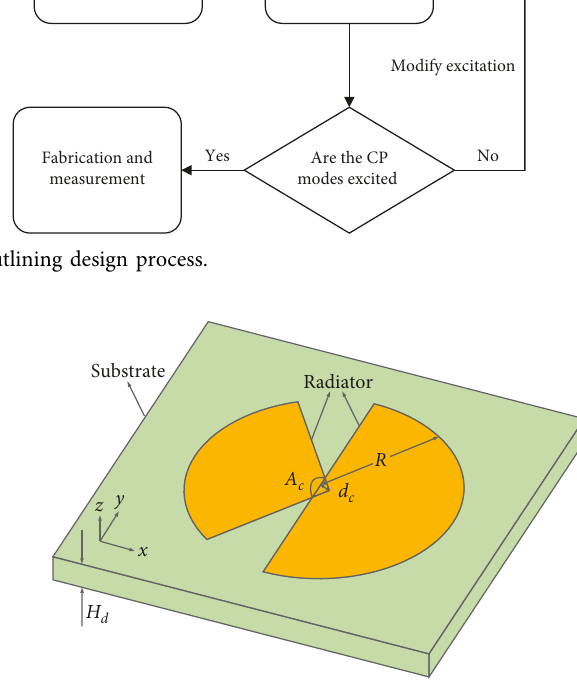
Figure 2: Geometry of the radiator. Dimensions: R �